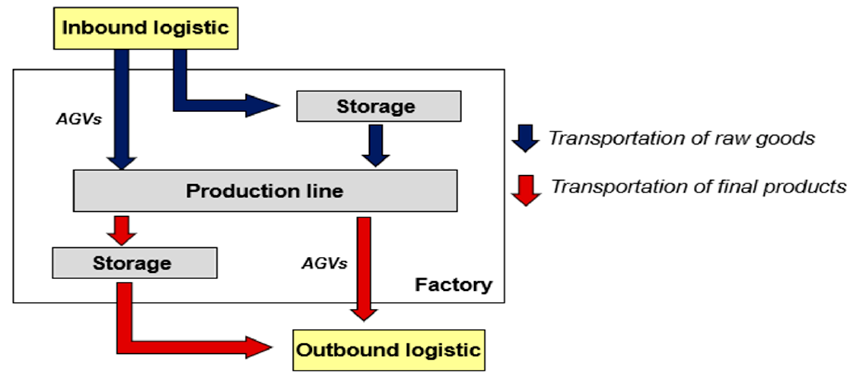
Figure 11. AGV scenario.